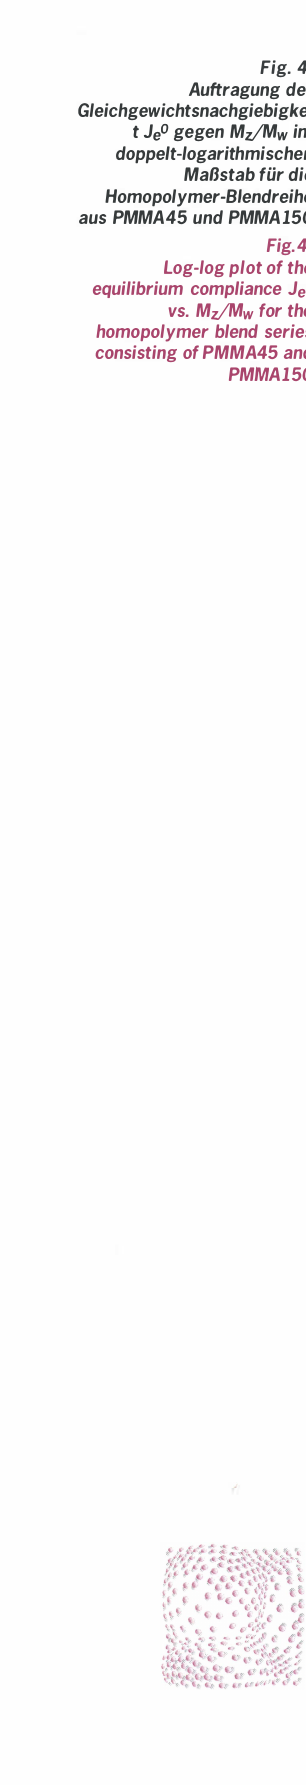
Fig.5. Relaxation time spectra for PMMA45 and PMMA150 and for three binary mixtures consisting of 20% (M2], 50% (M5}, and 80% (M8} high molecular weight content